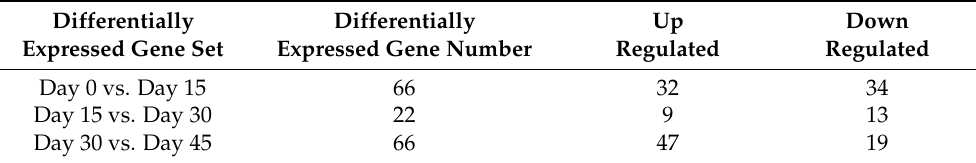
Table 1. Summary of differentially expressed MAPK cascade genes.